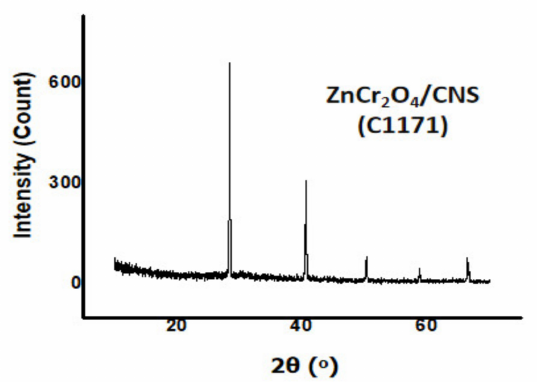
Figure 17. X-ray diffractogram of ZnCr 2 O 4 /CNS